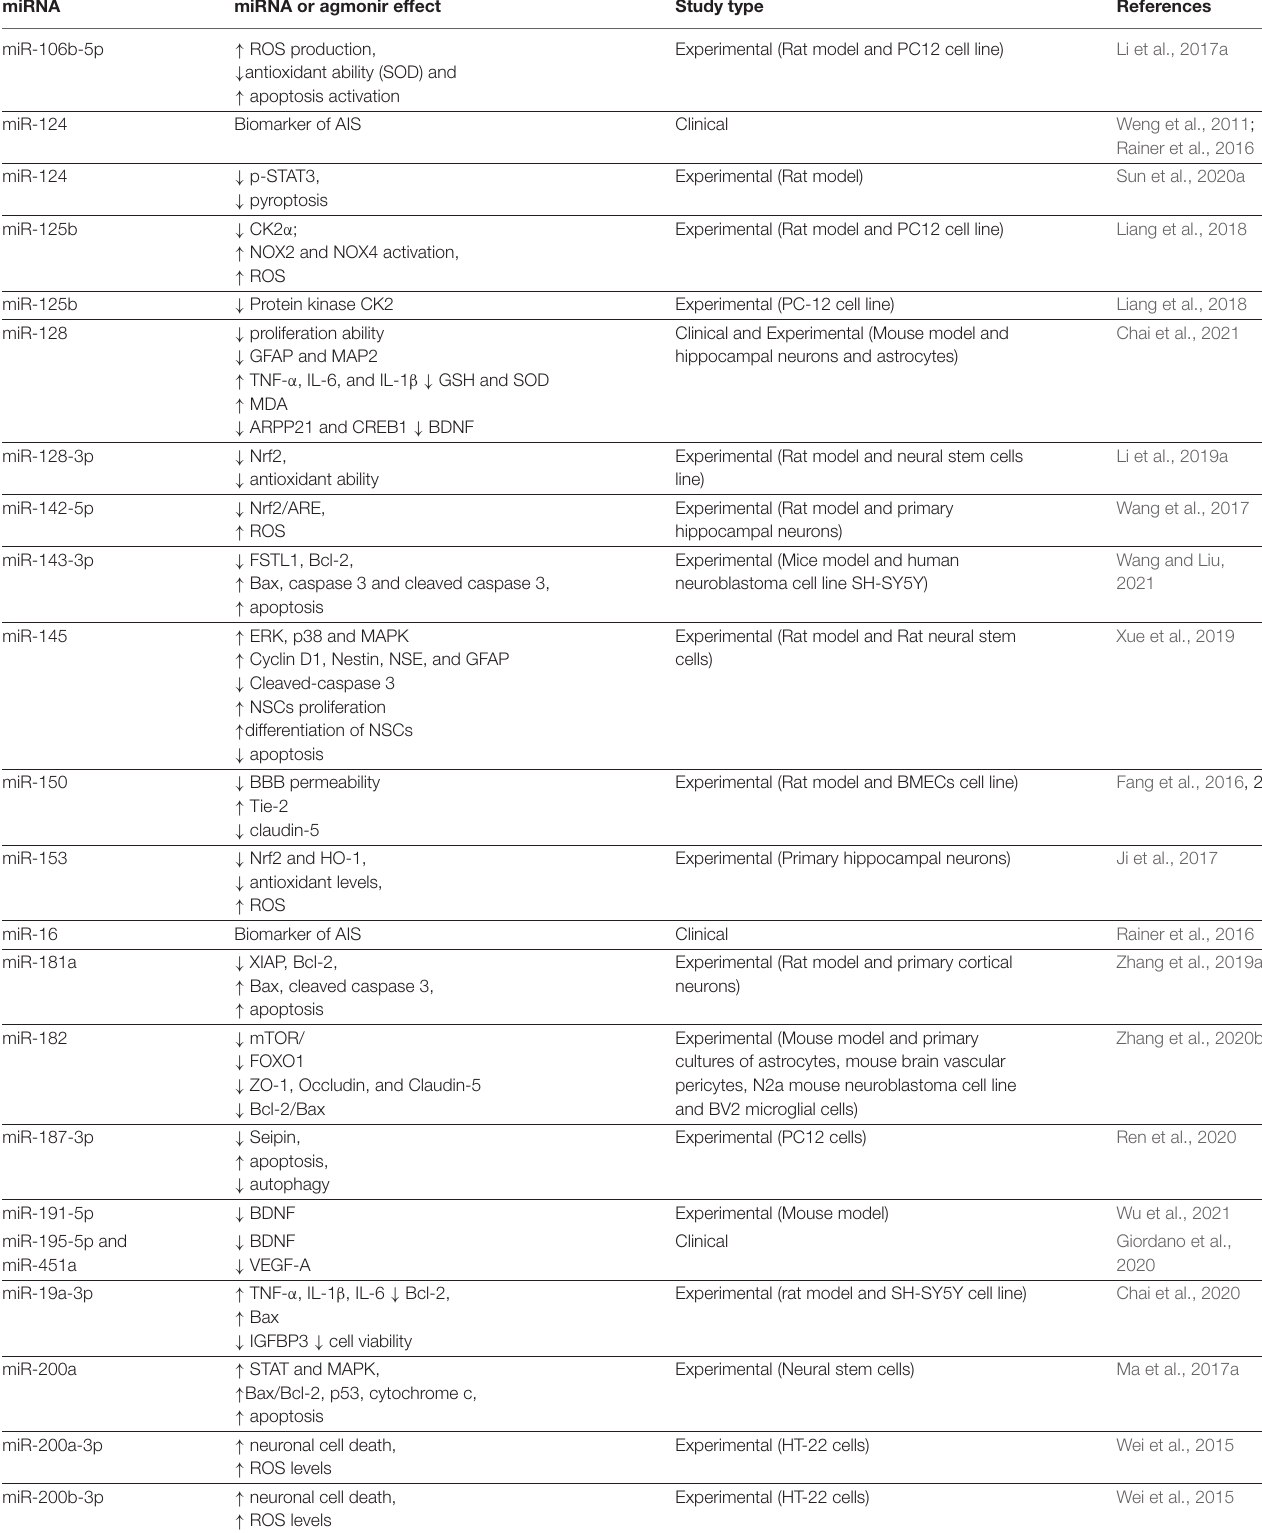
TABLE 1 | Up-regulated miRNAs in cerebral I/R